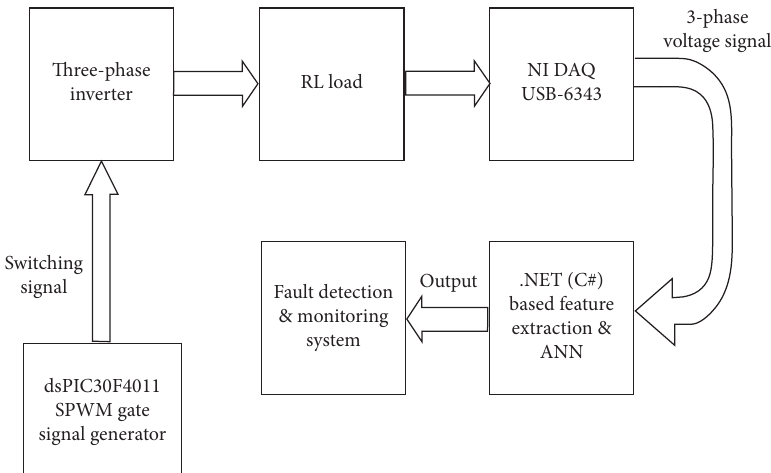
Figure 13: Hardware experimentation block diagram.